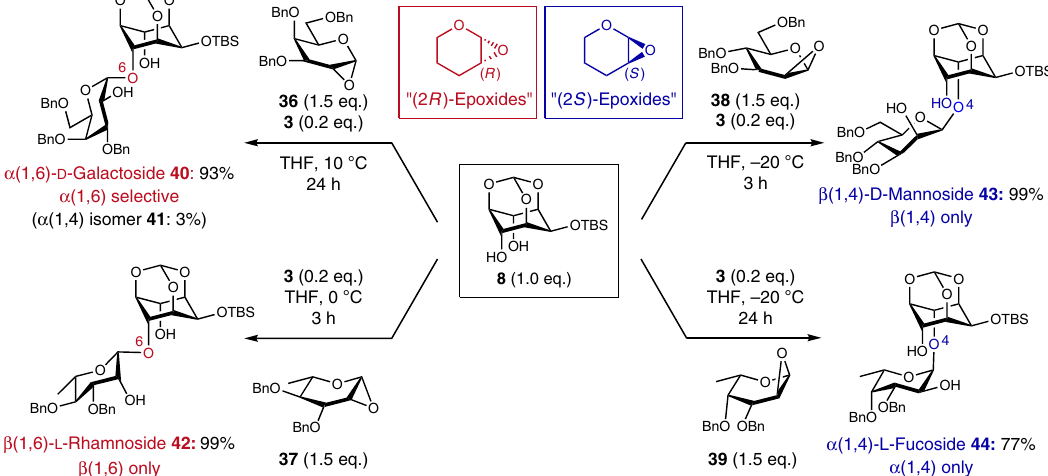
Fig. 5 Substrate scope of the glycosyl donors in the desymmetric glycosylation of 8. In all cases, the formation of 1.2- trans glycoside was not observed.